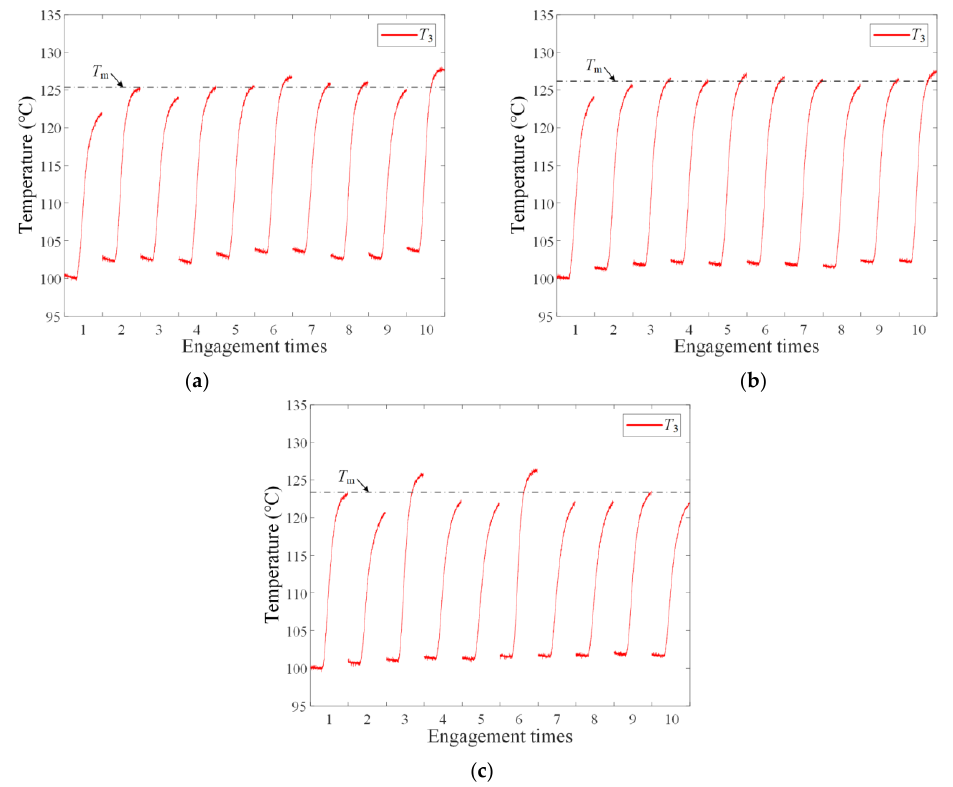
Figure 8. Experimental temperatures at different shifting intervals: ( a ) 10 s; ( b ) 14 s; ( c ) 18